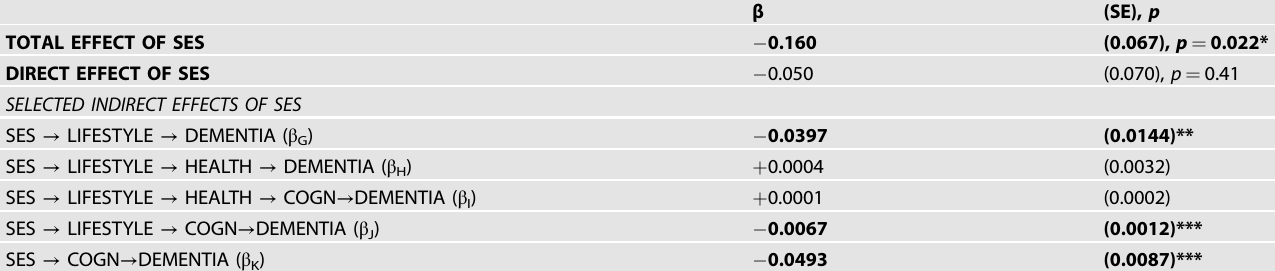
Fig. 1 GSEM model fi ndings for Non-White vs. NHW racial/ethnic contrast vs. DEMENTIA, NHANES III (1988 – 1994): Final eligible sample across income groups ( N = 4592). ALCOHOL alcohol consumption, z-score, COGN Cognitive performance principal component variable (4 measured variables), DIET/NUTR diet and nutritional biomarkers z-score variable (2 dietary quality measures and 4 nutritional biomarkers), HEALTH Health-related factors as mean of z-scores for allostatic load, self-rated health, co-morbidity index and body mass index, LIFESTYLE Lifestyle-related factors composed of social support, physical activity, diet/nutritional biomarkers, smoking and alcohol consumption using means of z-scores for related measured variables, MA Mexican American, N Number of participants, N ’ number of observations, NHANES III Third National Health and Nutrition and Examination Survey, NHB Non-Hispanic Blacks, NHW Non-Hispanic White, PA Physical activity z-score variable (3 measured variables), RACE_ETHN racial/ethnic contrast, SES Socioeconomic status mean of z-scores composed of poverty income ratio and education (years), SMOKING smoking z-score variable (2 measured variables), SS Social Support z-score variable (5 measured variables), TE Total effect; See Methods section for more details. Plain arrows are statistically signi fi cant associations (p < 0.05) within the hypothesized pathway; Dashed arrows are statistically signi fi cant associations ( p < 0.05) outside the hypothesized pathway; Red arrows are for positive ( + ) associations; Blue arrows are for inverse ( − ) associations. Table 4. Total, direct and selected indirect effects of modi fi able risk factors and cognitive performance from SES to incident all-cause dementia among older adults, overall (Age base : 60 + y); NHANES III, 1988 – 1994 a